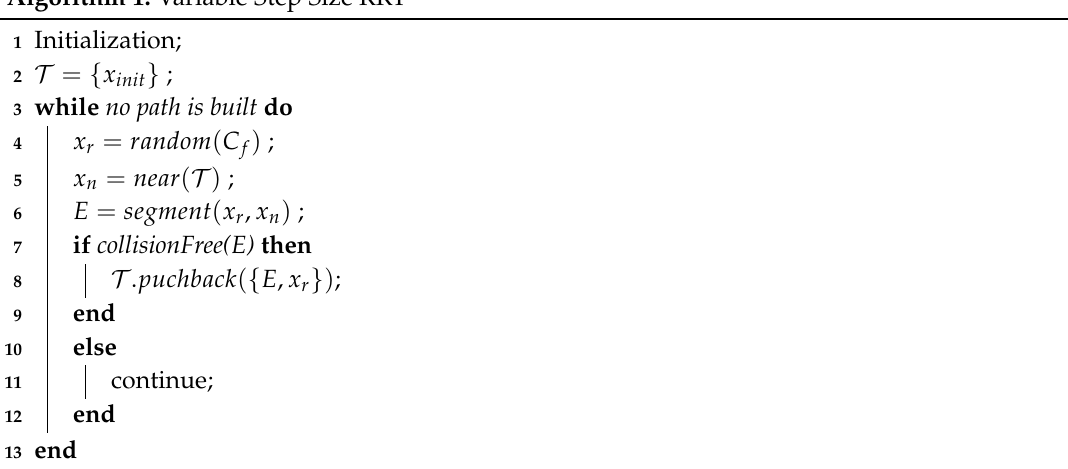
Algorithm 1: Variable Step Size